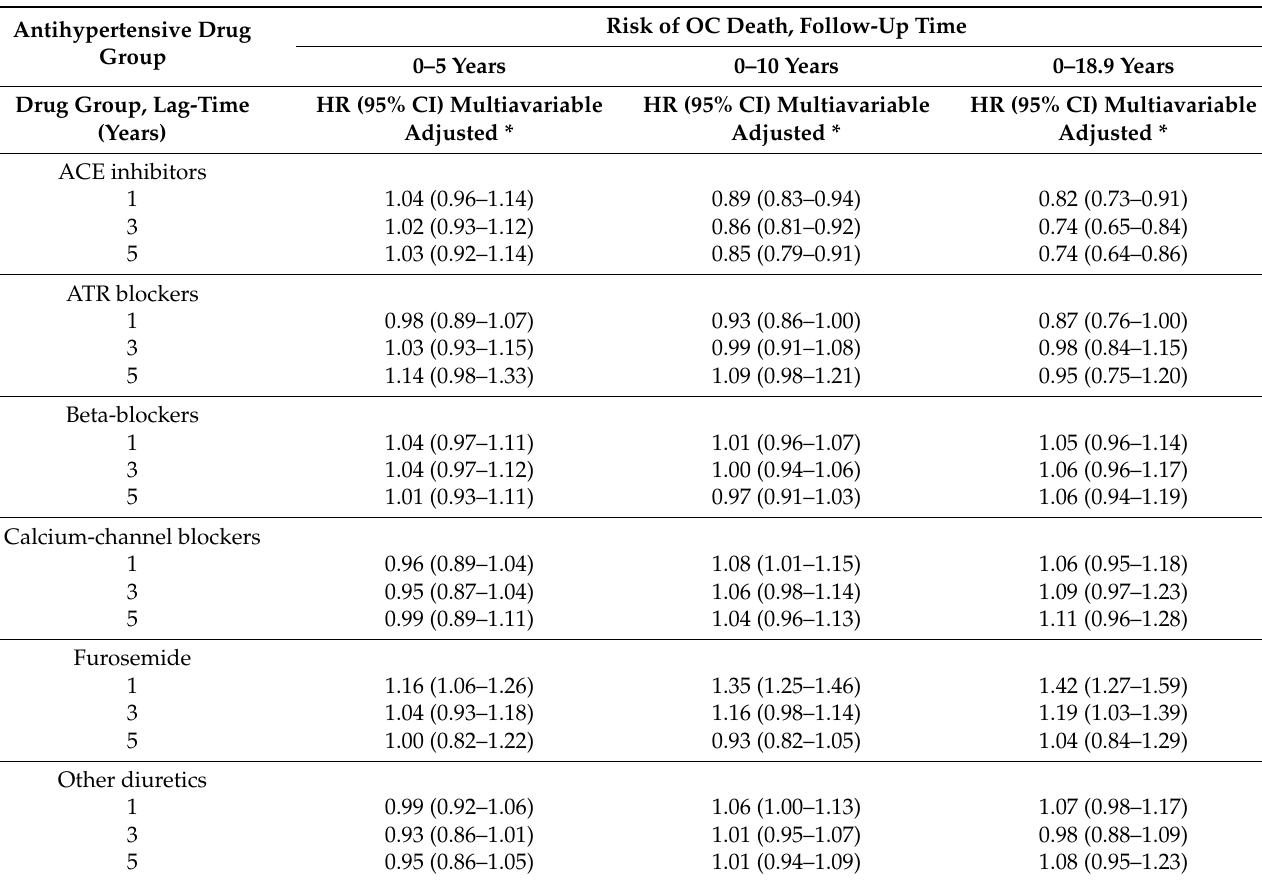
Table 4. Risk of OC death according to antihypertensive use after OC diagnosis. Use of antihypertensive drugs lagged for one, three and five